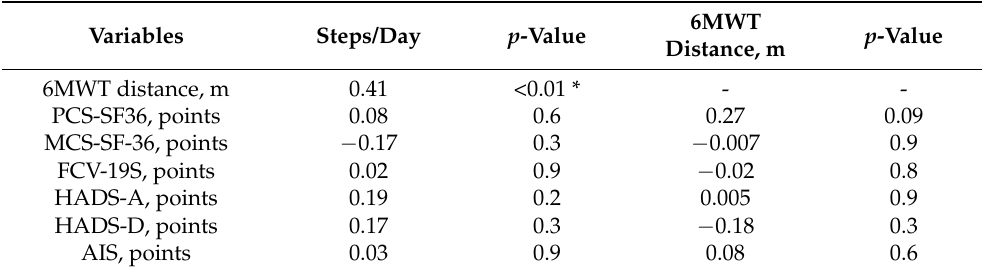
Table 4. Correlation between physical activity, 6 min walk test distance and quality of life, fear of COVID-19, hospital anxiety and depression, acceptance of the illness in PAH patients (n = 40). Variables Steps/Day p -Value Distance,